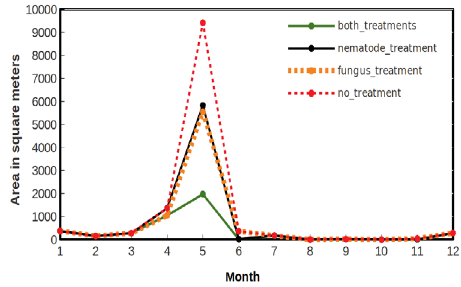
Figure 4. Graphic representation of the increase of the area of infestation one year in the